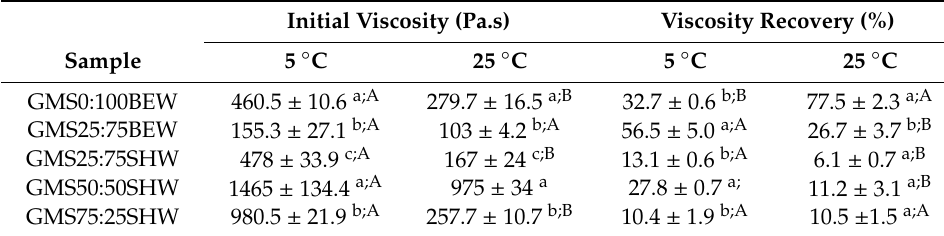
Table 1. Initial viscosity and viscosity recovery percentage in thixotropy measurements. Initial Viscosity